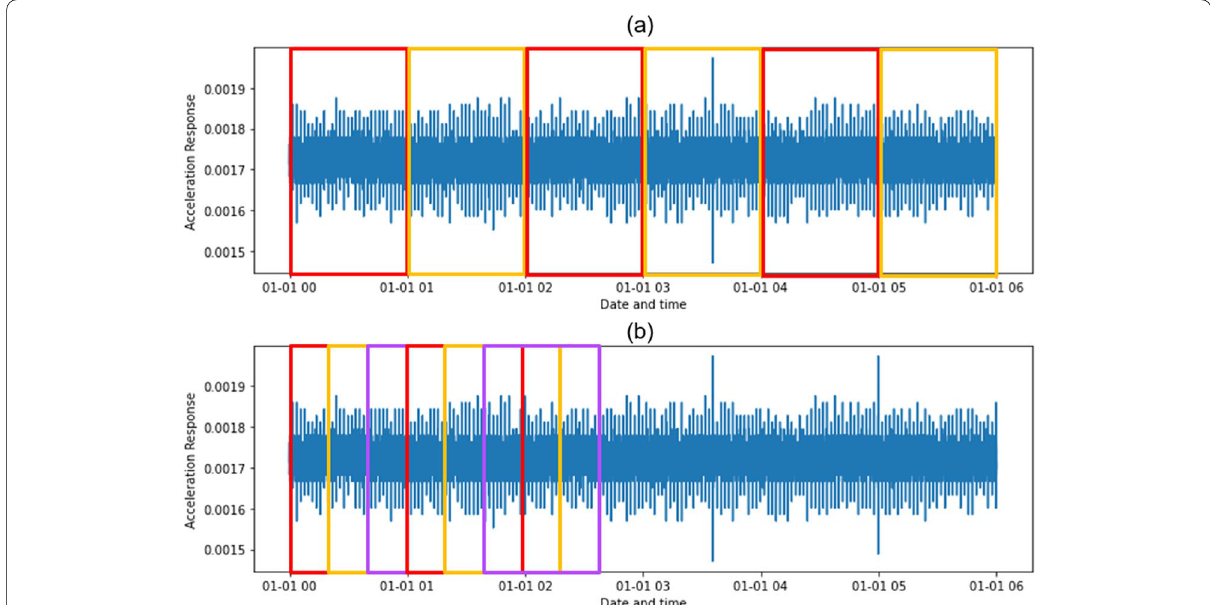
Fig. 1 Comparison between the number of data points needed between ( a ) non-overlapping hourly time shift and ( b ) shortened